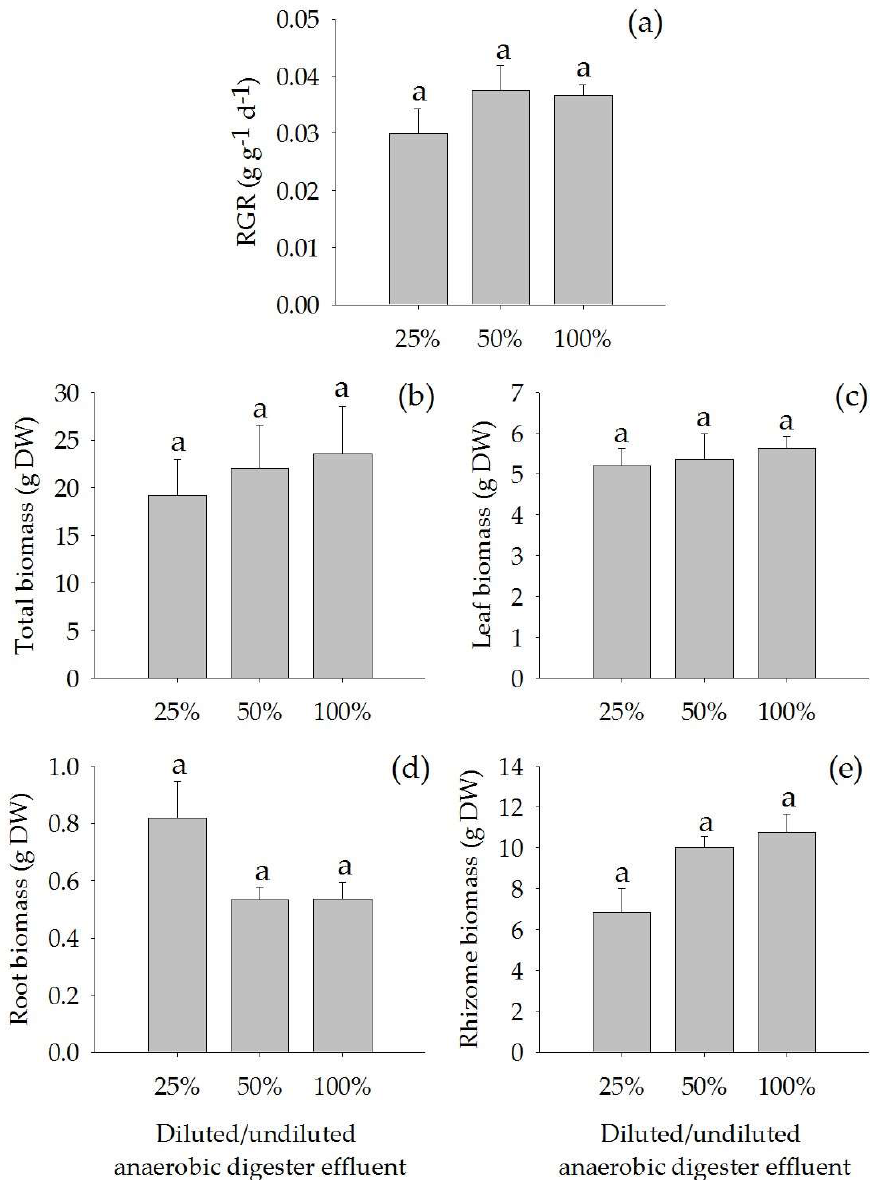
Figure 1. Relative growth rate (RGR) ( a ), total biomass ( b ), leaf biomass ( c ), root biomass ( d ) and rhizome biomass ( e ) (Mean ± SE) of Acorus calamus grown on diluted anaerobic digester effluent (25% and 50%) and undiluted anaerobic digester effluent (100%) for a period of 56 days.